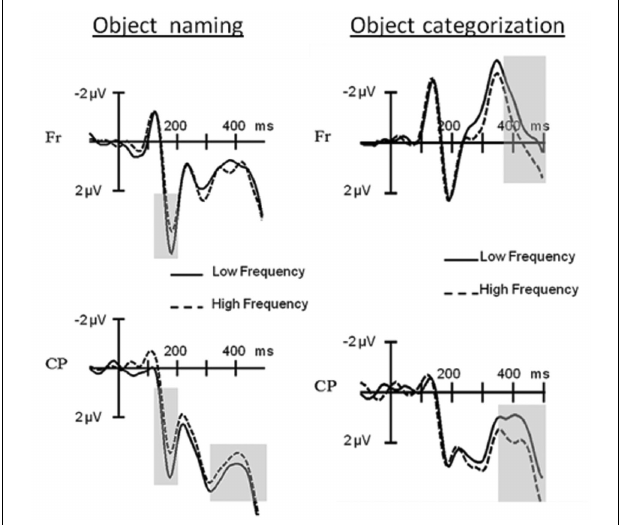
FIGURE 5 | Event-related potential results for object naming versus object categorization. At the left hand side: ERPs elicited during object naming by pictures with low compared to those with high frequency names at Frontal (Fr) and Centro-Parietal (CP) electrode clusters. Grayed areas show significant frequency effects at the P2 and N400. At the right hand side: ERPs elicited during object categorization by pictures with low compared to those with high frequency names at Frontal (Fr) and Centro-Parietal (CP) electrode clusters. Grayed areas show significant frequency effects at the N400. (Figure taken and adapted from Experiments 1 and 2 in Strijkers et al.,